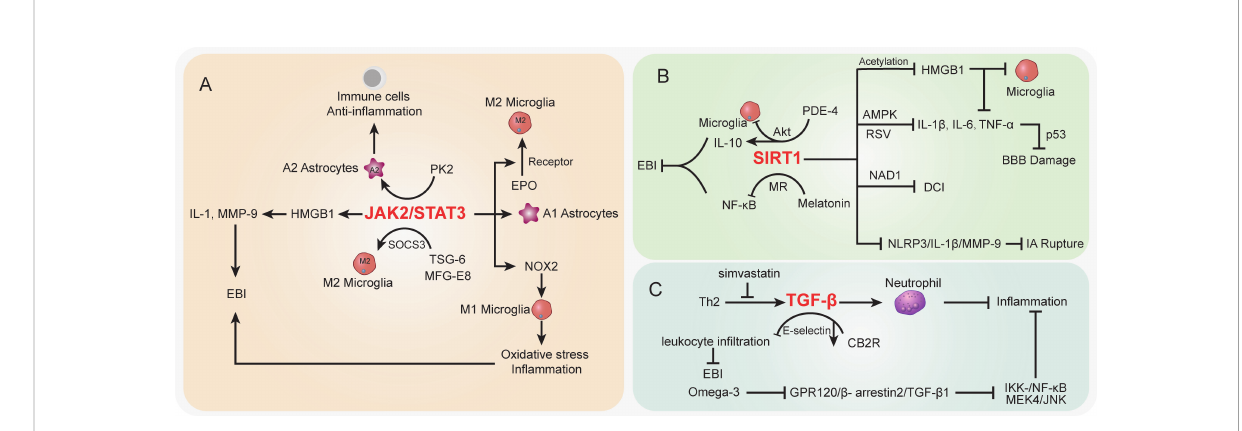
FIGURE 3 The speci fi c role played by STAT (A) , SIRT1 (B) , and TGF- b (C) pathways in disease development following